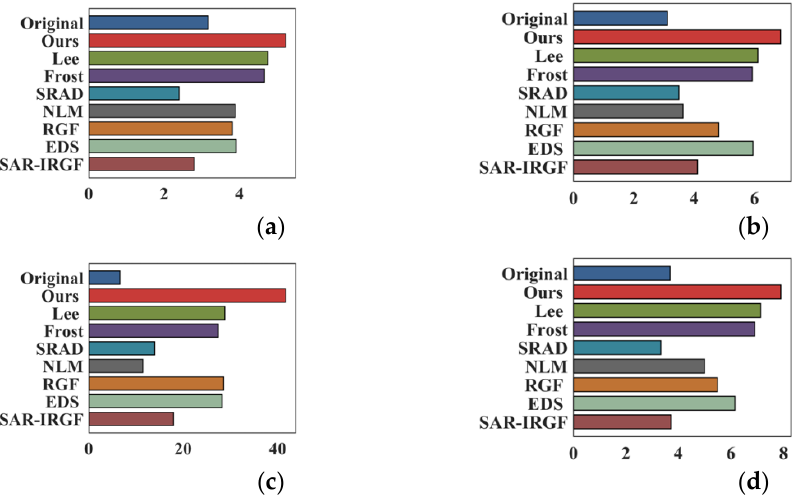
Figure 20. ENL results for the regional parts of speckle suppression images: ( a – d ) are the ENL results corresponding to subregion 1 to 4, respectively.